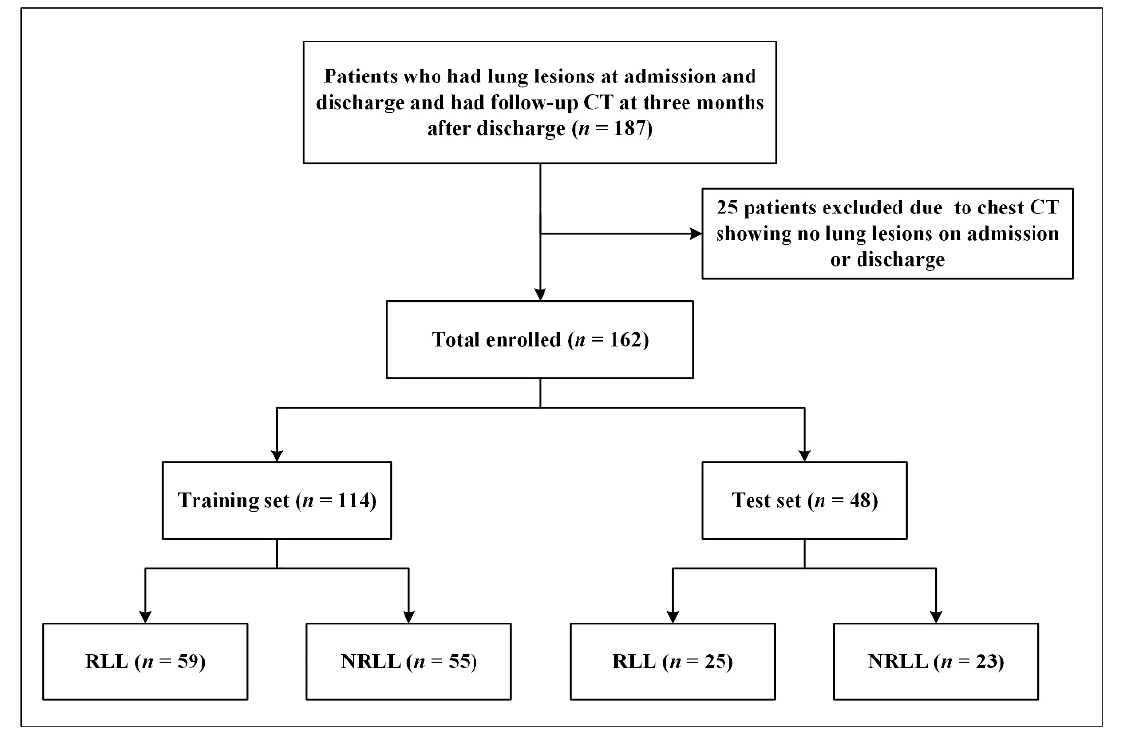
Figure 2. Patient flowchart .